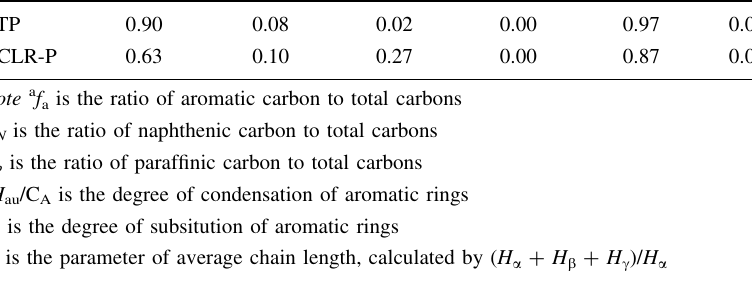
Table 3 1 H-NMR analysis of CTP and DCLR-P Samples